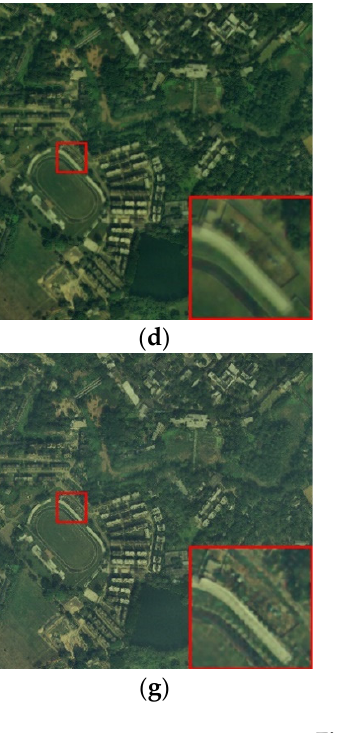
Figure 11. Real experiment results using the QuickBird dataset. ( a ) IHS, ( b ) HPF, ( c ) PRACS, ( d ) Wavelet, ( e ) PNN, ( f ) FusionNet, ( g ) Pansformers, ( h ) LNFIN, ( i ) LRMS.